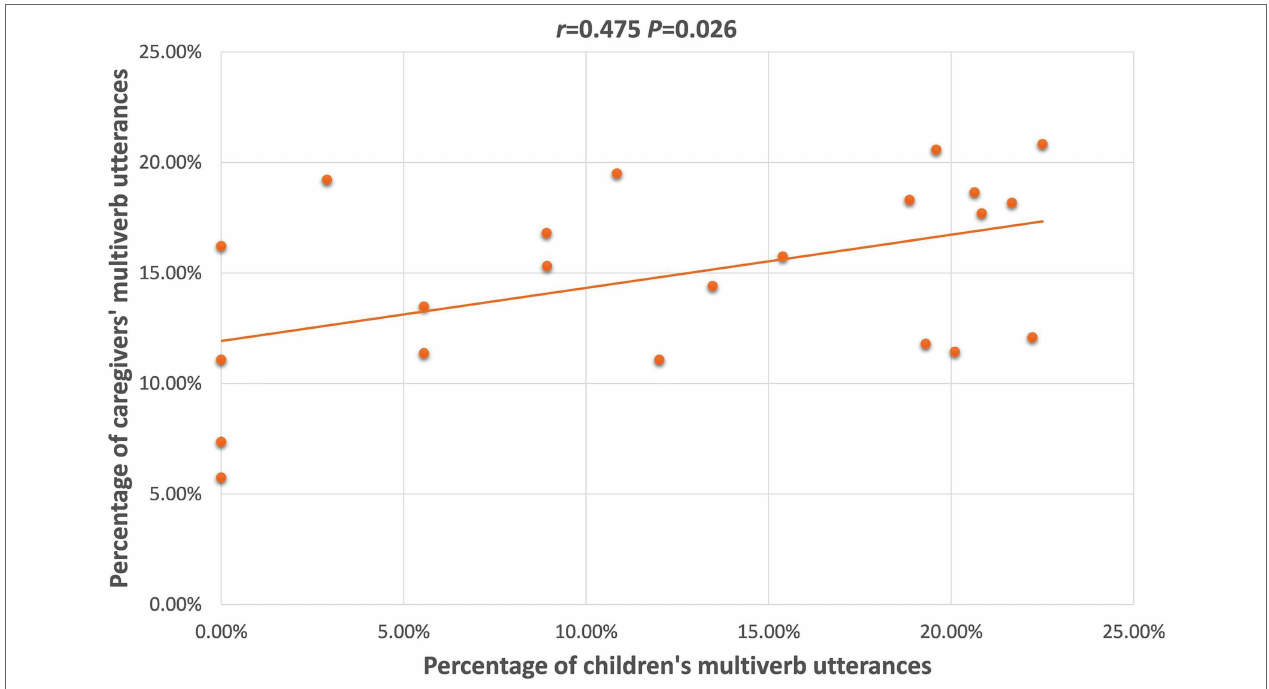
FIGURE 5 | Scatterplot of children with ASD’s and caregivers’ Multiverb utterances, combined